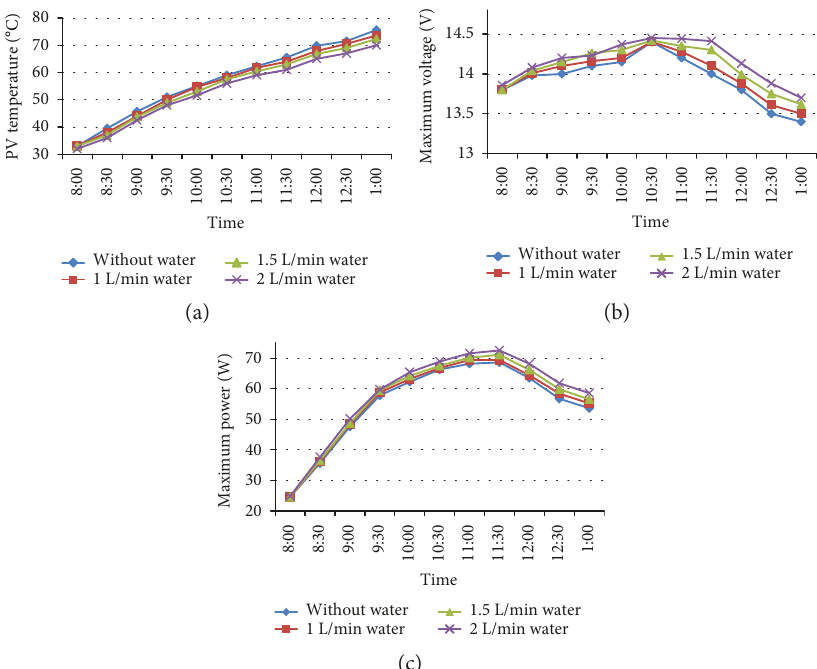
Figure 7: (a) E ff ect of mass fl ow rates on the PV temperature. (b) E ff ect of mass fl ow rates on the voltage. (c) E ff ect of mass fl ow rates on the PV power.